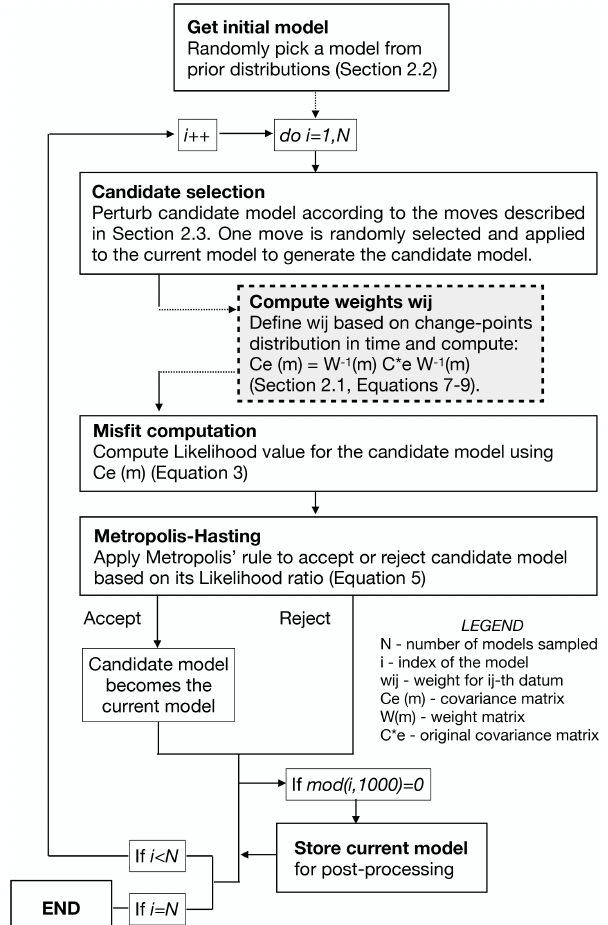
Figure 2. Flowchart of the algorithm. The grey-shaded box indi- cates the element which can be shared on multiple CPUs on a clus-